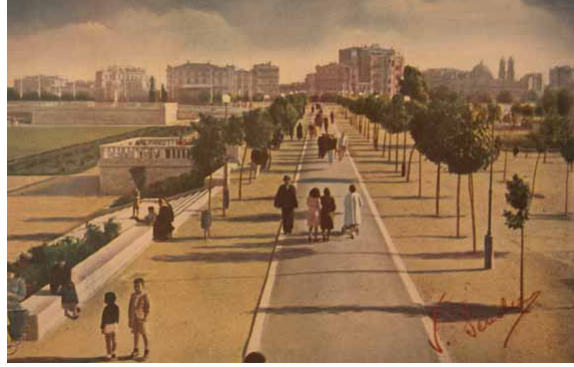
fig. 1. republican Monument in Taksim Square c. 1928